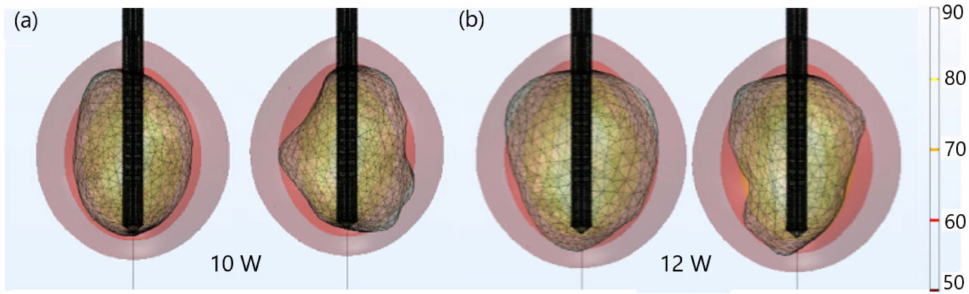
Figure 7. Iso-contours associated with various temperatures (solid colored surface) around tumors (triangulated surface) ( a ) 1.07 [51] (for an input power of 10 W) and ( b ) 1.03 [51] (for an input power of 12